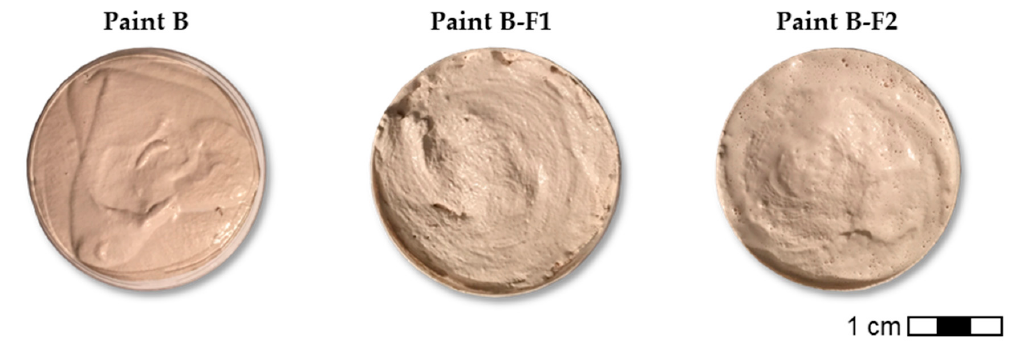
Figure 2. Aspect of Paint B after and before the addition of fillers.